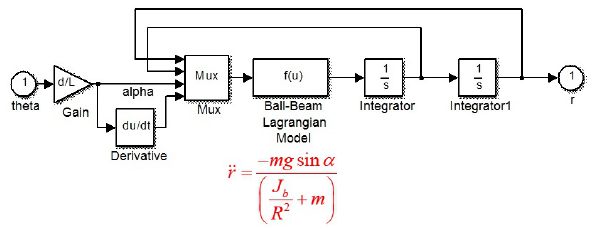
Figure 2: System Dynamics Modelling.